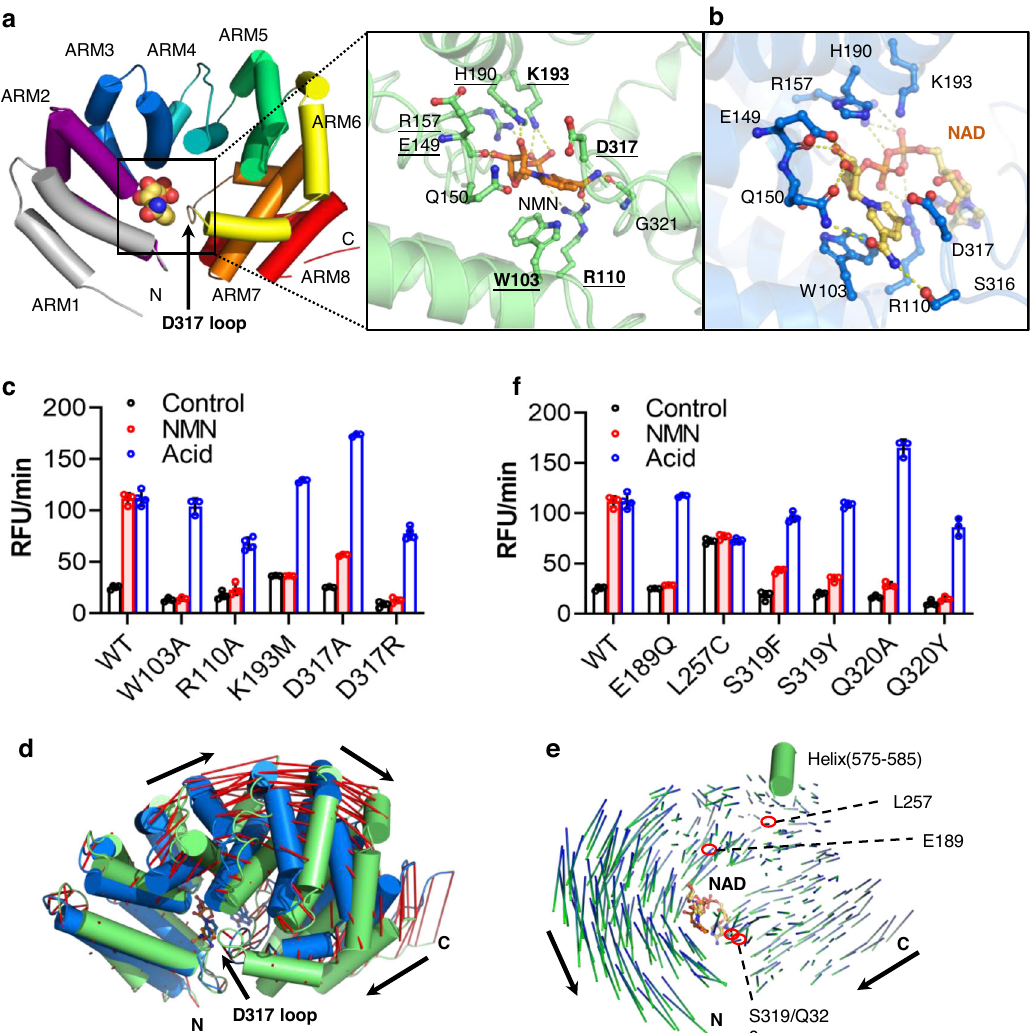
Fig. 4 | Conformational changes of the ARM domain induced upon NMN binding. a The structure of ARM NMN . ARM domain is shown as cartoon, with separate armadillo motifs in different colors, and NMN molecule is shown as sphere. The D317 loop is indicated with a black arrow. The right panel shows the zoom-in view of the NMN-binding pocket. NMN and the NMN-interacting residues areshownasball-and-stickmodels, withNMNcoloredwithgold carbonatomsand aminoacidswithgreencarbonatoms.Hydrogenbondsareshownasyellowdashed lines. The residues mutated in this work are labeled in bold and the reported mutationswithunderlines. b ThebindingpocketofNADinARMdomain.SARM1 NAD (PDB 7ANW) is superimposed onto SARM1 NMN at the same orientation of panel a. AminoacidsareshownwithbluecarbonatomsandNADwithyellowcarbonatoms. c , f The constitutive activity and NMN-responsiveness of the SARM1 mutants. HEK293 cells carrying the inducible expression cassette for the mutants were